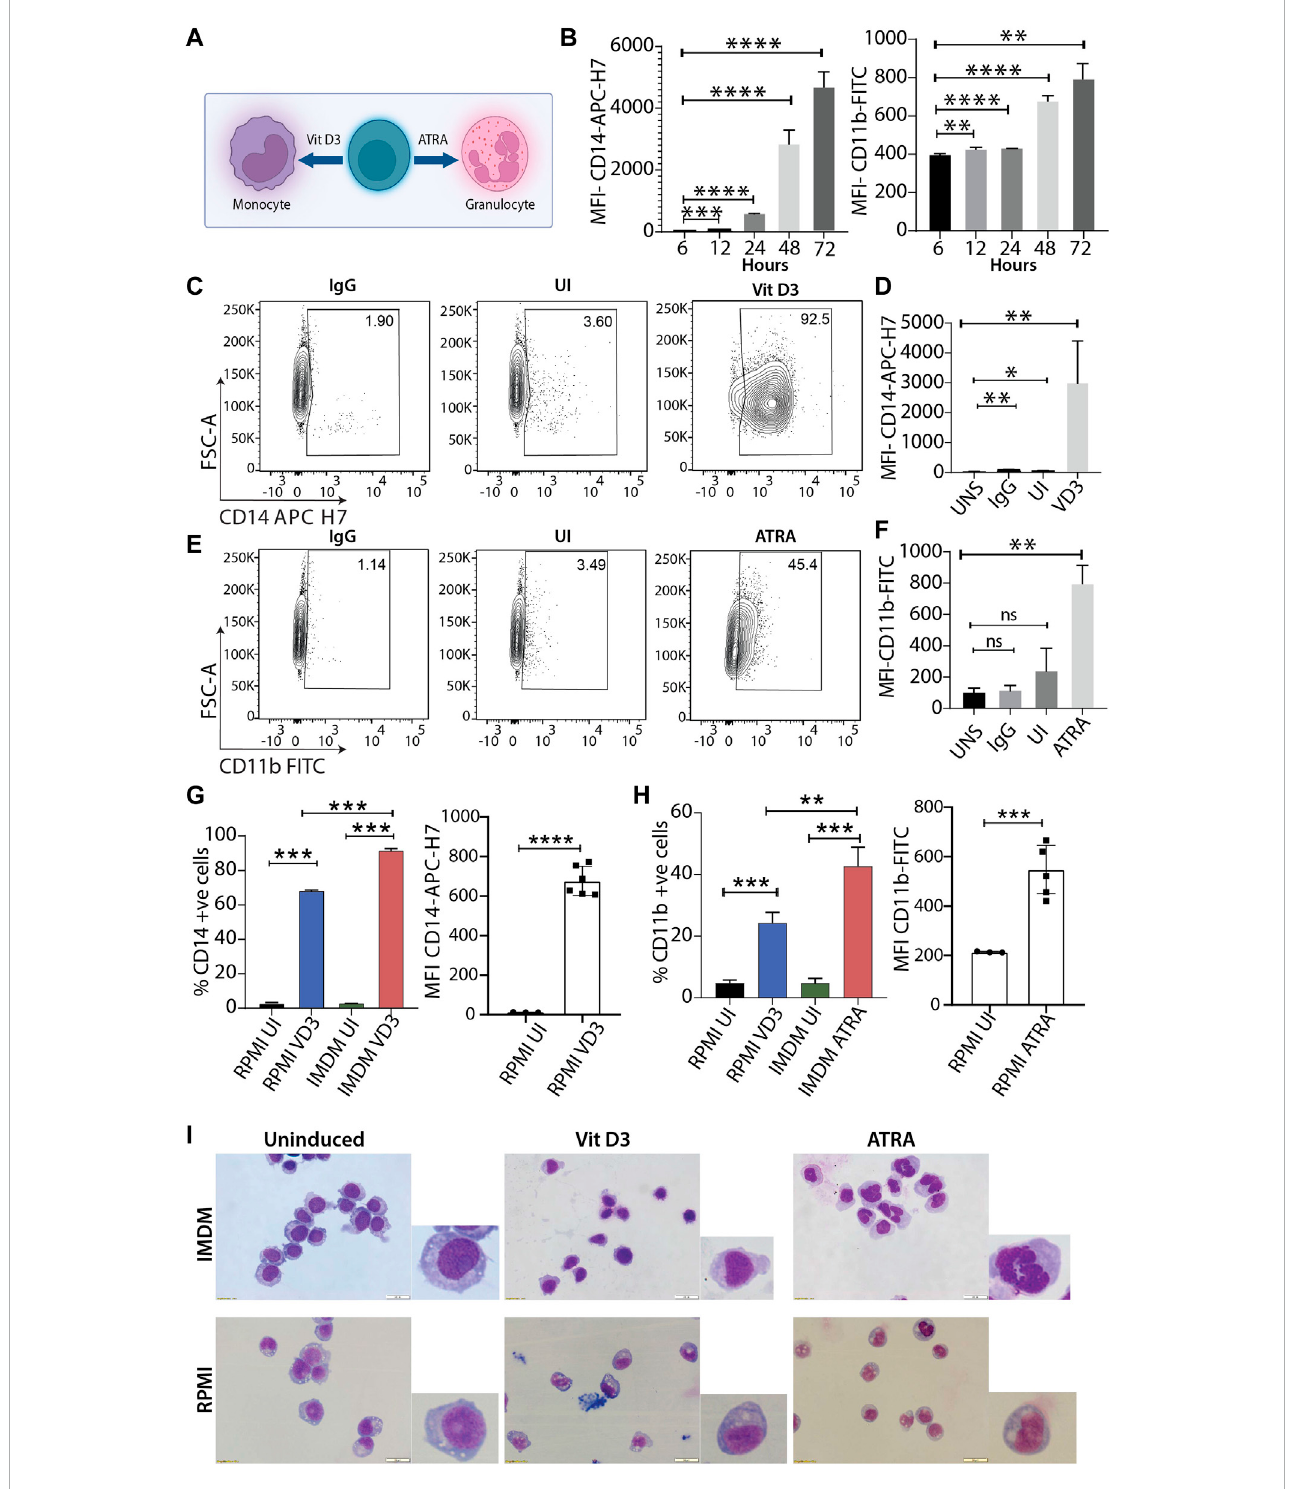
Differentiation of HL60 model system using two different culturing conditions. (A) Schema of HL60 myeloid differentiation model into monocytes and granulocytes using vitamin D3 (Vit D3) and all-trans retinoic acid (ATRA) respectively. (B) Bar plot shows mean fl uorescence intensity (MFI) of CD14-APC- H7 and CD11b-FITC at 6, 12, 24, 48 and 72 h of induction time points with Vit D3 and ATRA (** = 0.01, *** = 0.001, **** = 0.0001). An unpaired t -test was performedtaking a6hdata pointas areferenceusingGraphPadPrismversion8.2.1. (C) Contour plotsshowinggating ofstainedcellswith IgG-APC-H7, followedbystaininguninducedcells,andVitD3inducedHL60cells(72 hinduction)withCD14-APCH7(fromlefttorightcontourplots).The X -axisand Y -axis ofthecontourplotsshowCD14-APCH7andforwardscatter(A=area)respectively. (D) BarplotsrepresentingMFIoftheCD14-APCH7intensityat72 hpost- Vit D3 induction. The MFI of CD14-APC H7 positive cells were compared with unstained cells (UNS), IgG, and uninduced cells (UI) (* = ≤ 0.05, ** = 0.01). An unpaired t -test was performed using GraphPad Prism version 8.2.1. (E) Similar to panel C, HL60 cells were induced with ATRA for 72 h and IgG-FITC and CD11b-FITC were used in this experiment. The X -axis and Y -axis of the contour plots show CD11b-FITC and forward scatter (A = area) respectively. (F) Bar